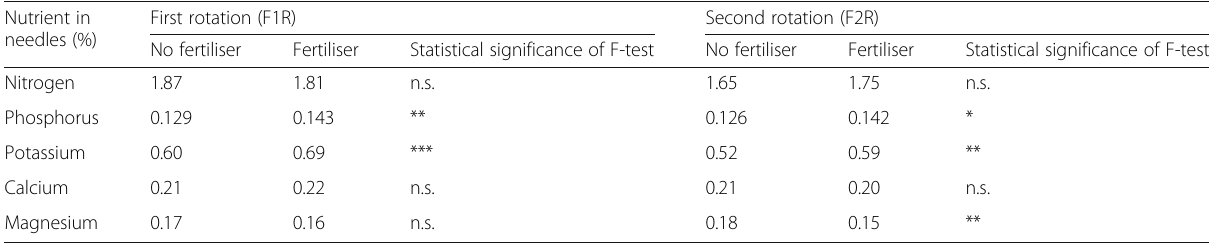
Table 5 The influence of fertiliser on needle nutrient concentration at age 10 years across all five sites of the first trial series established in 1971